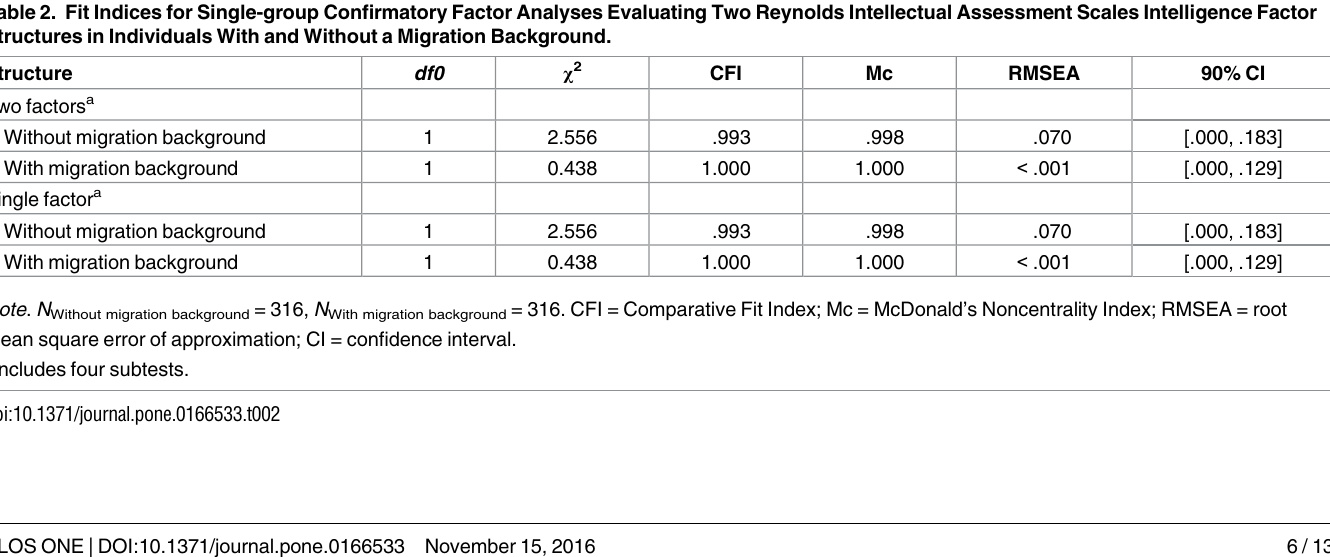
Table 2. Fit Indices for Single-group Confirmatory Factor AnalysesEvaluating Two Reynolds Intellectual Assessment Scales Intelligence Factor Structures in Individuals With and Without a Migration Background. Structure Two factors a